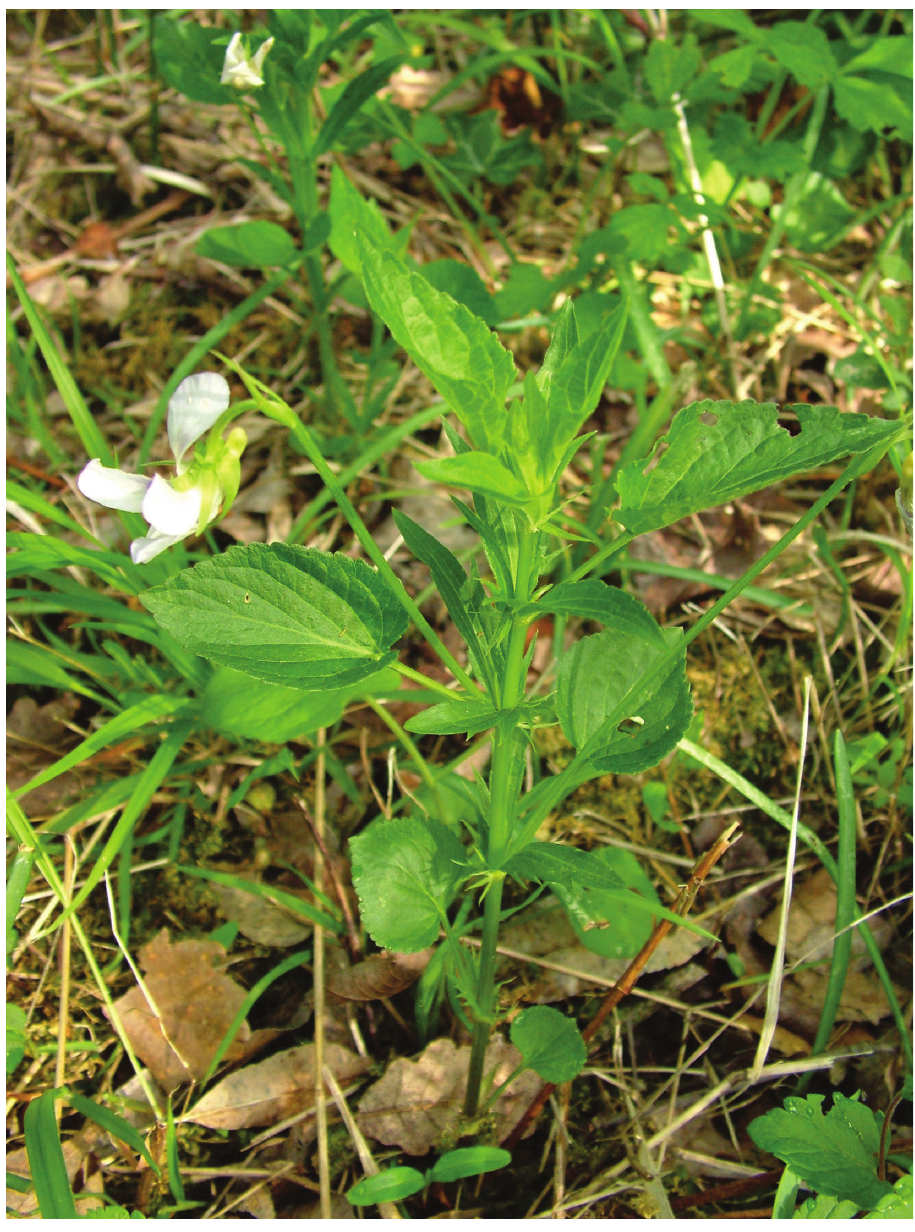
Figure 11. Viola jordanii from Lake Doberdò (Friuli Venezia Giulia). Photograph by M. Castello.